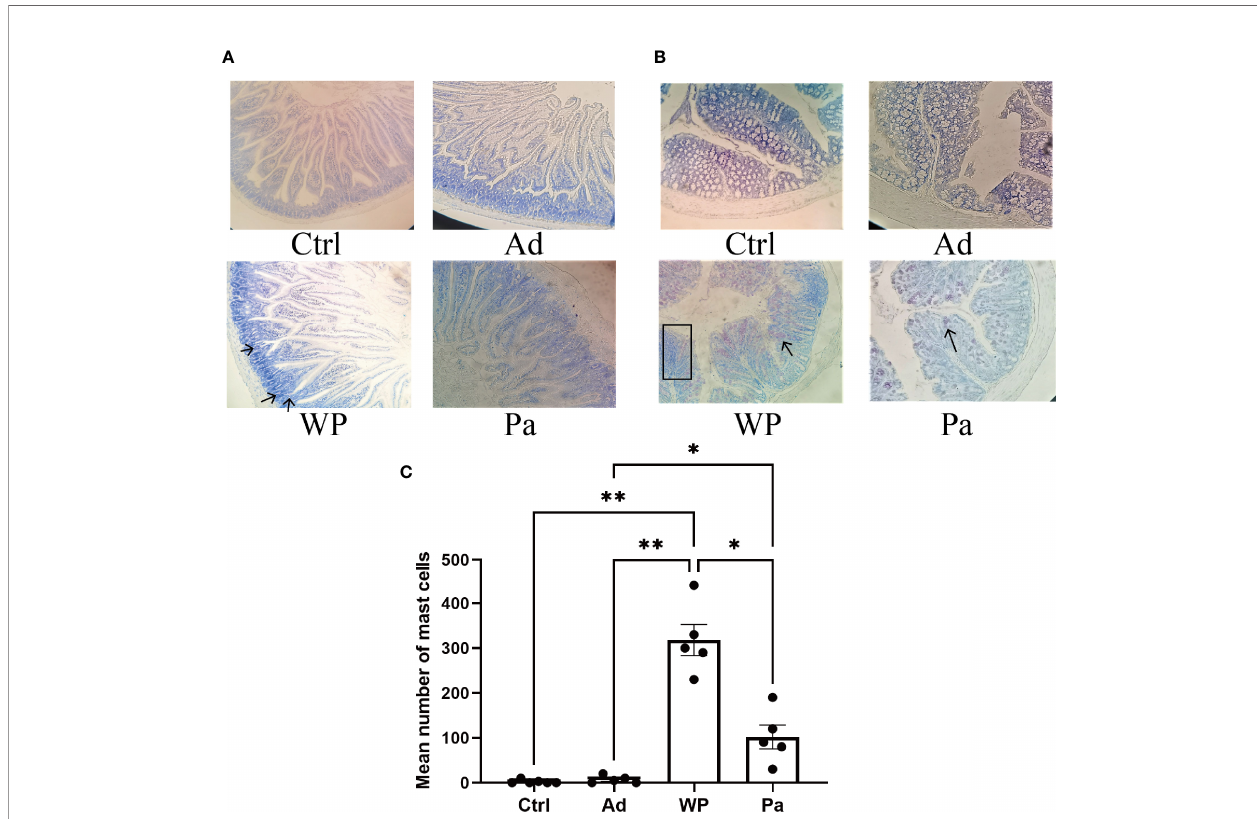
FIGURE 4 | The mast cells in the duodenum (A) and colon (B) were stained with toluidine blue. The red arrow indicates in fi ltration of in fl ammatory cells. The total number of mast cells in the duodenum and colon is shown in (C) . n = at least 5 mice per group. Data are shown as the mean value ± standard error of mean. The asterisk indicates a statistically signi fi cant difference ( P <0.05). The stained gut sections were photographed with a Leica microscope at ×100 magni fi cation. The black box indicates in fi ltration of in fl ammatory cells. The black arrows indicate mast cells (red